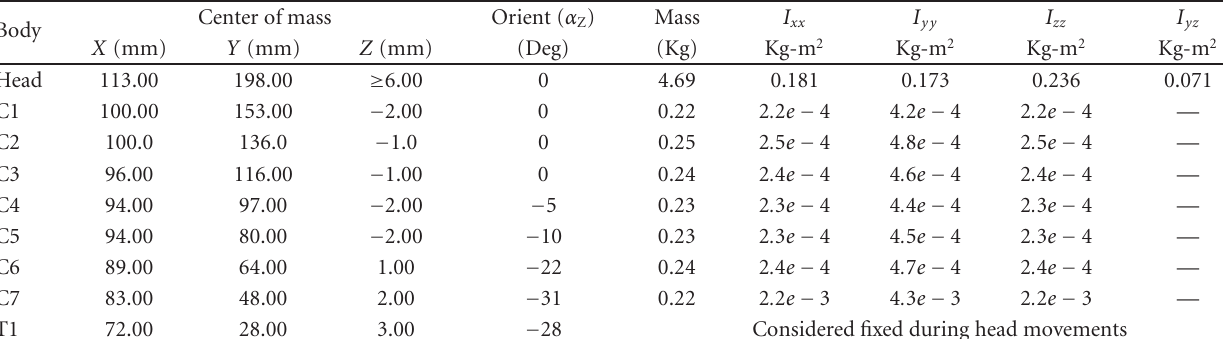
Table 1: Geometric characteristics and inertial parameters for bony structures in the complex. Adapted from (Chang et al. [26] and van Lopik and Acar [6]).